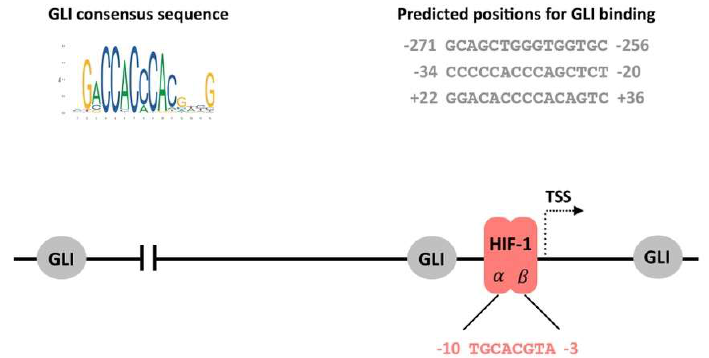
Figure 3. GLI consensus sequence (left side) and prediction of GLI binding sites (right side) within the CA9 promoter were acquired using JASPAR software. The position of three predicted GLI binding sites is outlined in relation to the hypoxia-responsive element (HRE; the sequence recognized by HIF-1 transcription factor) located -10/-3 upstream from the transcription start site (TSS).